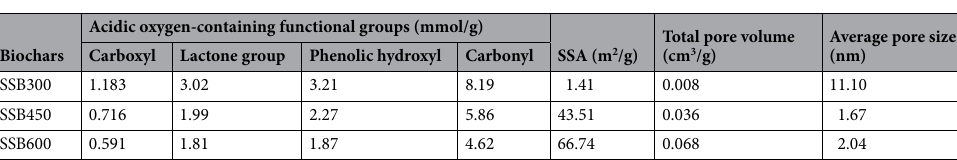
Table 1. The physicochemical properties of sorghum straw biochar.